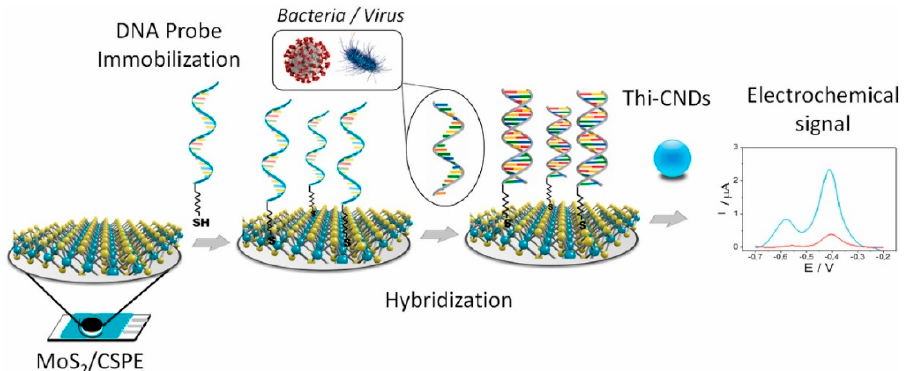
Figure 10. Schematic diagram of a DNA-MoS 2 platform and thionine-carbon nanodots for detecting the nucleic acids of ORF1ab in SARS-CoV-2 and DNA of Listeria monocytogenes. The figure is reprinted with permission from Ref. [116]. Copyright Elsevier Ltd. (2021).